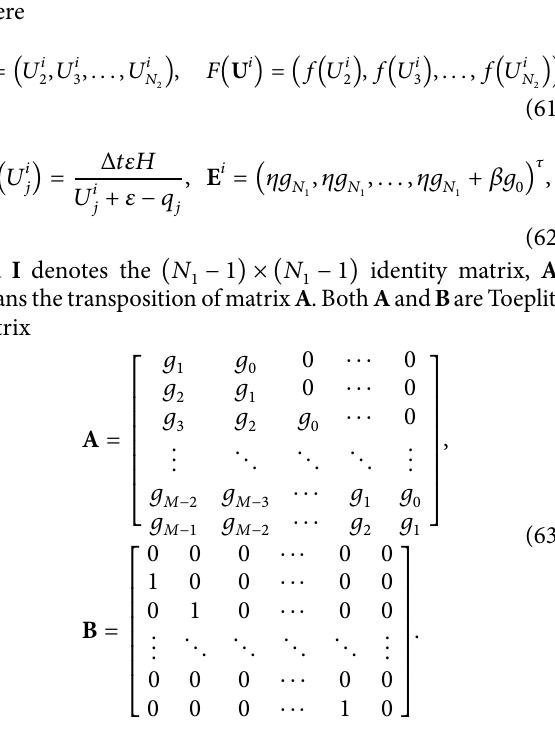
Figure 1: Mesh surface of 𝐷 = 0.1, 𝐶 = 0.03, 𝐺 = 1.2, 𝑀 = 1, 𝑌 = 1.5, 𝑇 = 2, 𝐾 = 50